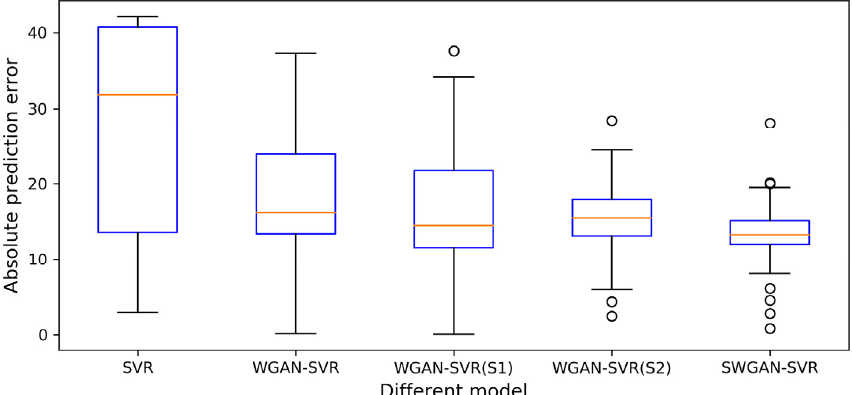
Figure 7. Absolute values of the prediction errors for the numerical example.